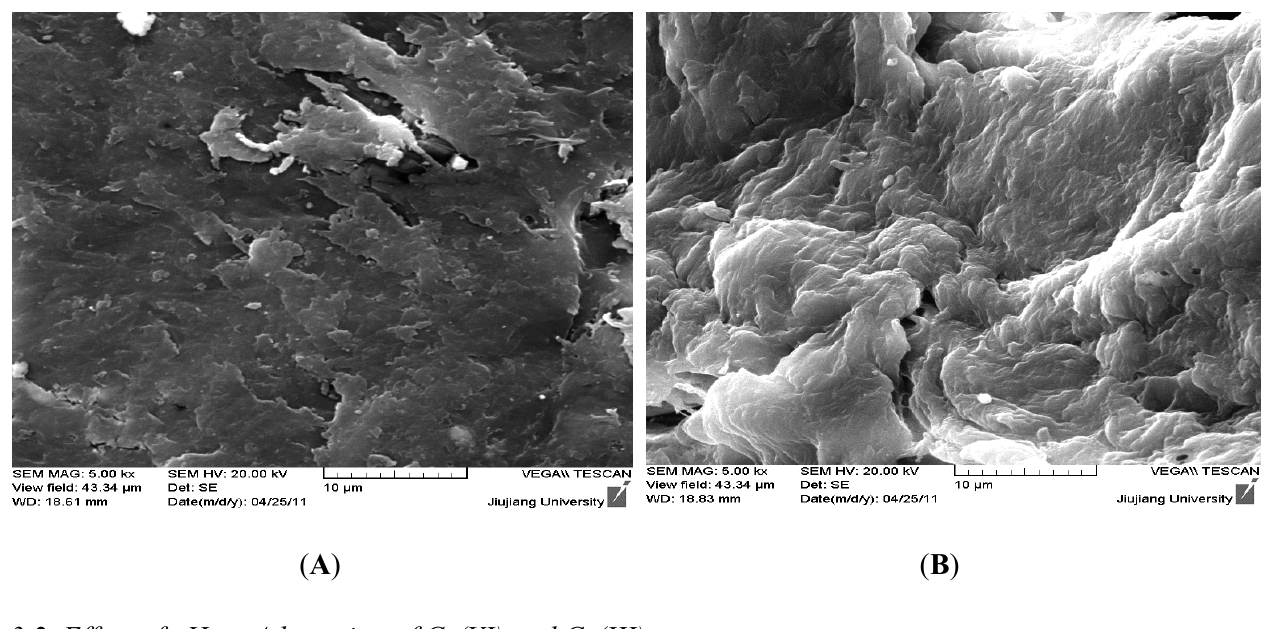
Figure 2. SEM images of ( A ) CTS and ( B )